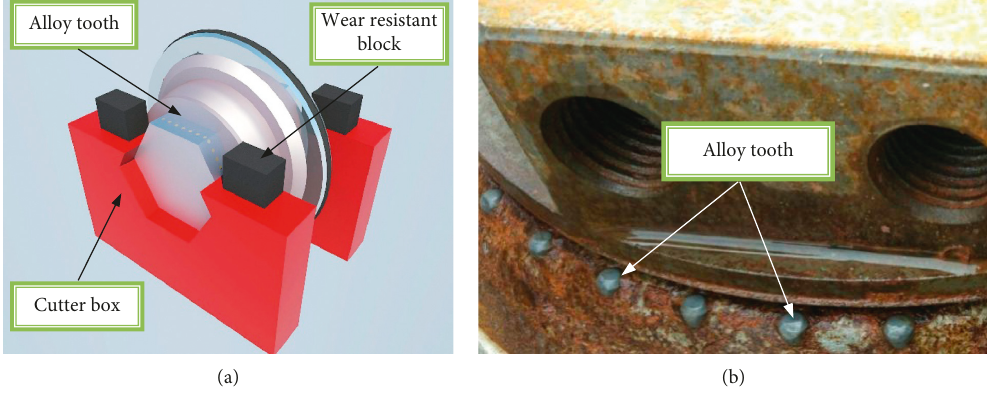
Figure 9: Picture of the wear on the cutter hub.